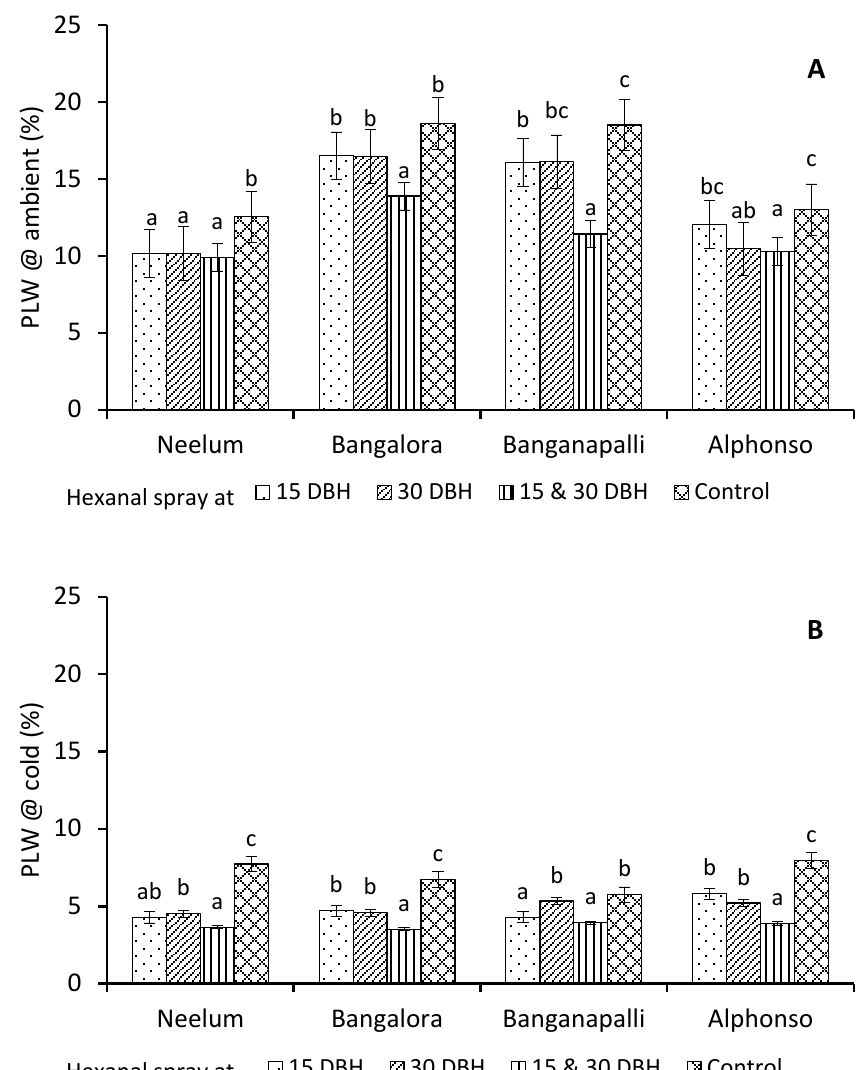
Figure 3. Mean PLW of hexanal-treated and control mango fruits of four cultivars towards the end of their storage life under ambient ( A ) and cold ( B ) storage conditions. The vertical bars in the columns represent the standard error of four replicates (n = 15). The columns with different and the same letters indicate statistical significance and non-significance respectively ( p = 0.05). DBH—Days before harvest.